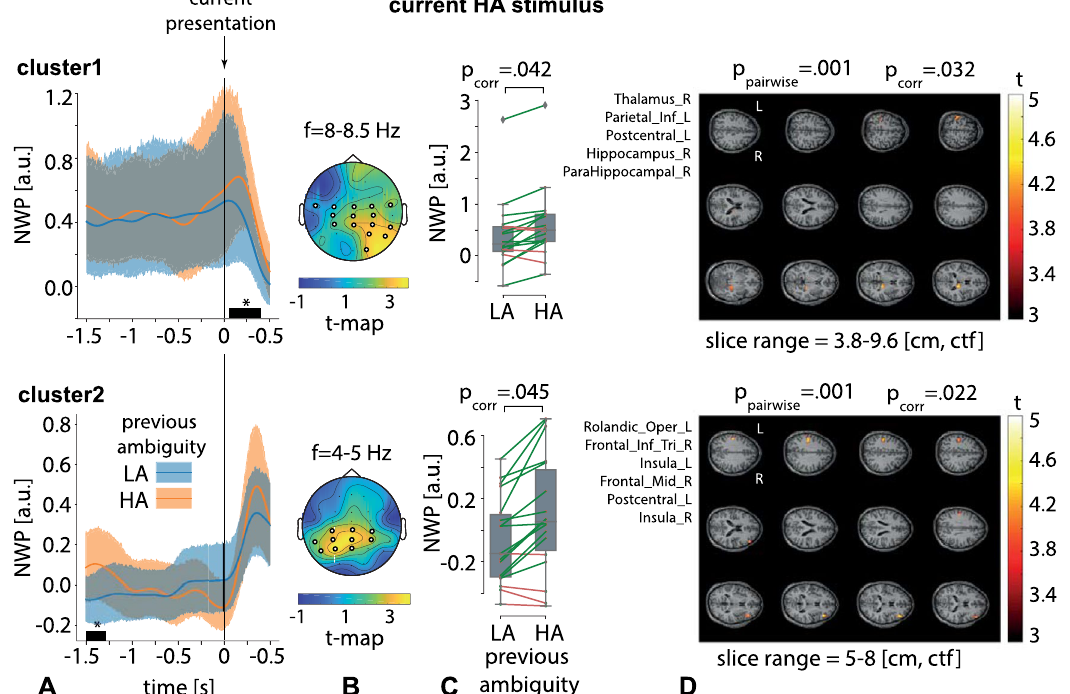
Figure 5. Two significant clusters as the result of NWP comparison during HA stimuli processing following the HA and LA stimuli on the 2 s interval time-locked to stimulus onset (vertical solid line). The blue and orange curves ( A ) show evolution of the NWP (group means and 95% CI) in these clusters during HA stimuli processing following the LA and HA stimuli. The scalp topogram ( B ) reflects t -value, and the channels demonstrating a significant change of NWP between analyzed conditions on the EEG sensor level. The box-plot ( C ) illustrates NWP in this cluster averaged over the time interval, frequency band, and channels. The slice-plot ( D ) reflects the t -value for the voxels demonstrating a significant change of the source power. p corr is corrected for multiple comparisons via the cluster-based test with the Monte-Carlo randomization